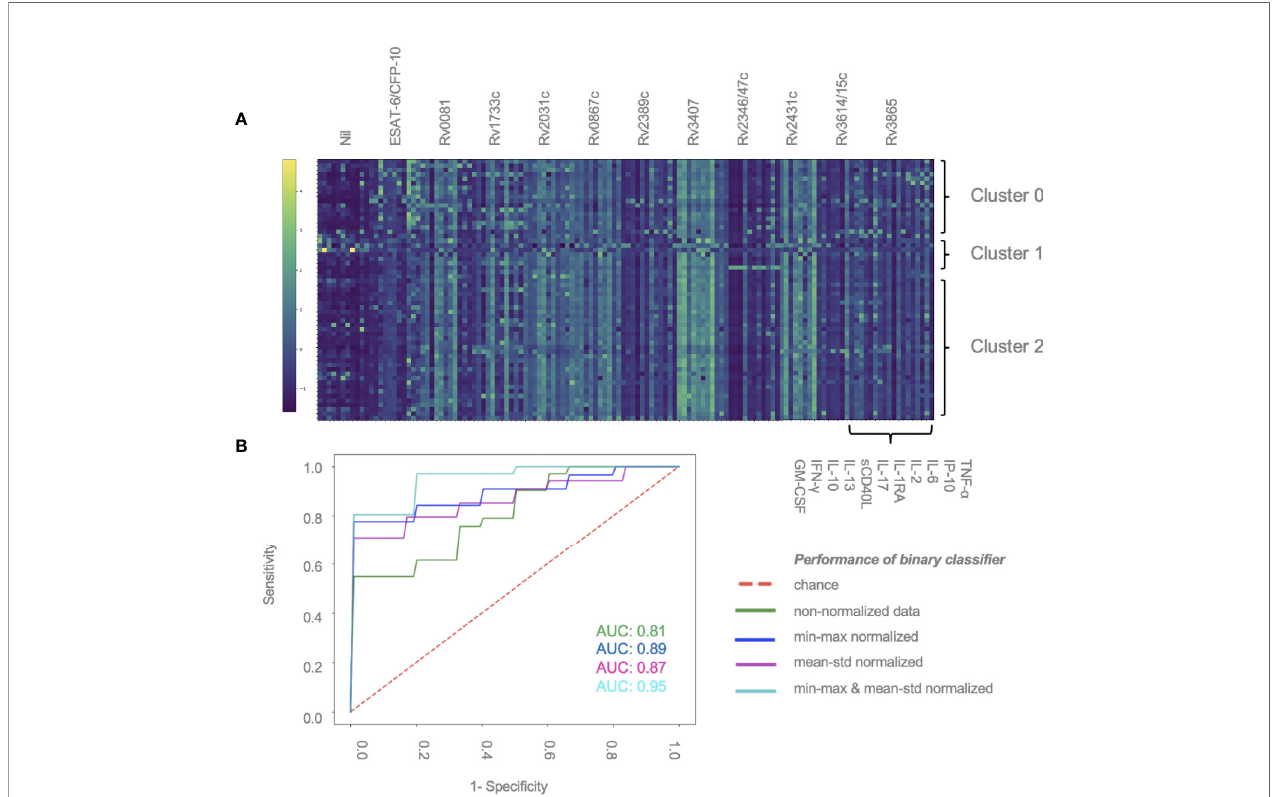
FIGURE 2 | Normalization of data contributes to performance of discriminative classi fi er (A) Cytokine concentrations for individual patients. Results are sorted by patient group and clusters (2, 1 or 0), and antigen – cytokine pairs. Clustering was performed using K-means algorithm. Min – max normalization was applied to cytokine – antigen concentrations, mean – std normalization was applied to between-individual measurements (color change from dark blue to light green represents an increase in relative cytokine concentration). (B) AUROC curve showing the performance of the binary classi fi er (con fi rmed/uncon fi rmed TB and TB infection versus TB exposed) in 59 patients using different normalization methods: min – max and mean – std; normalization of antigen – cytokine pairs; min – max/mean-std combining an antigen – cytokine pair normalization with individual patient